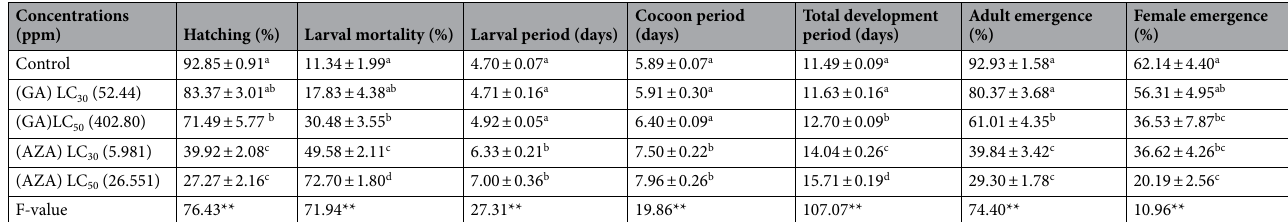
Table 8. Development and survival of B. hebetor larvae emerged from S. litura larvae fed on gallic acid and azadirachtin supplemented diet. **Significant at 1%, *Significant at 5%, ns Non significant. Values are Mean ± SE. Means followed by the same letter within the columns are not significantly different according to Tukey’s test at p ≤ 0.05.GA (Gallic acid), AZA